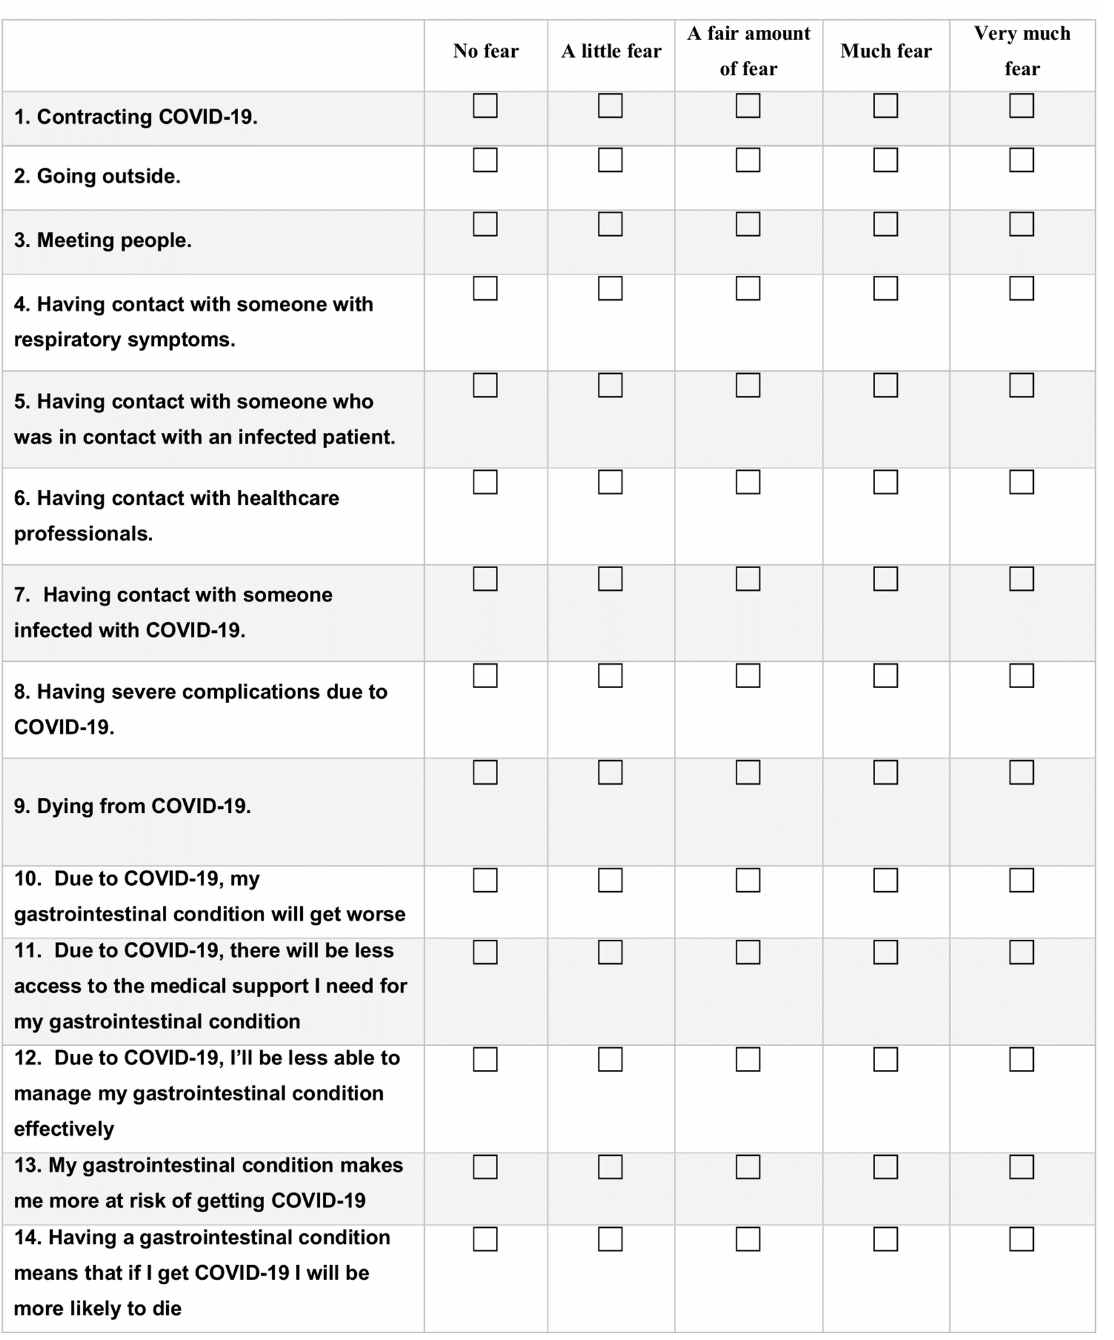
Supplementary Figure 1. Fears relating to COVID-19